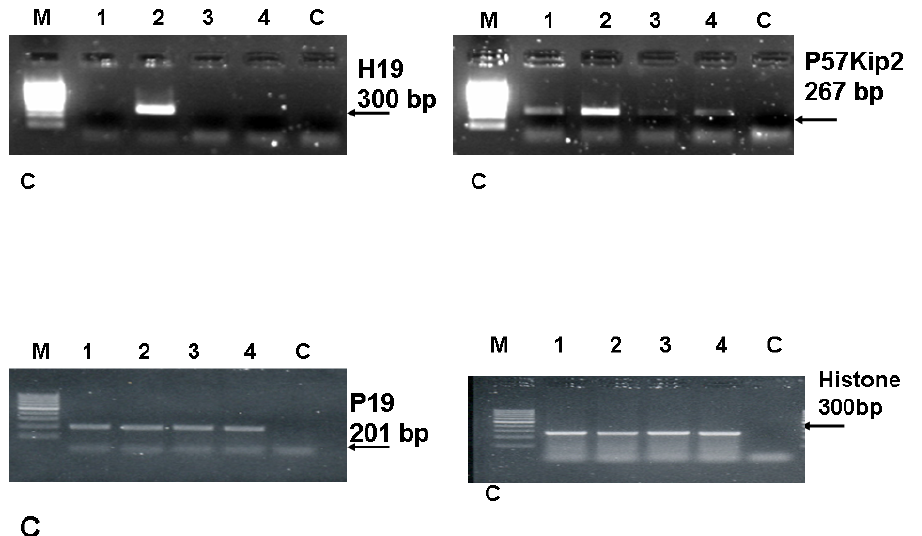
Figure 7. H19 RNA knockdown impedes p57Kip2 mRNA induction in response to hypoxic stress, in Hep3B cell line. Hep3B cells were seeded and transfected either with H19 siRNA or Luc siRNA as described . Shown are RT-PCR analyses for H19 RNA (28 PCR cycles). (A): Hep3B transfected with luc siRNA (lanes 1, 2) and H19 siRNA (lanes 3, 4) both in normal (lanes 1, 3) and hypoxic (lanes 2, 4) culture conditions, respectively. And similar treatments are assessing the mRNA levels of: (B). p19 INK4 (C). p57 Kip2 (D). Histone.